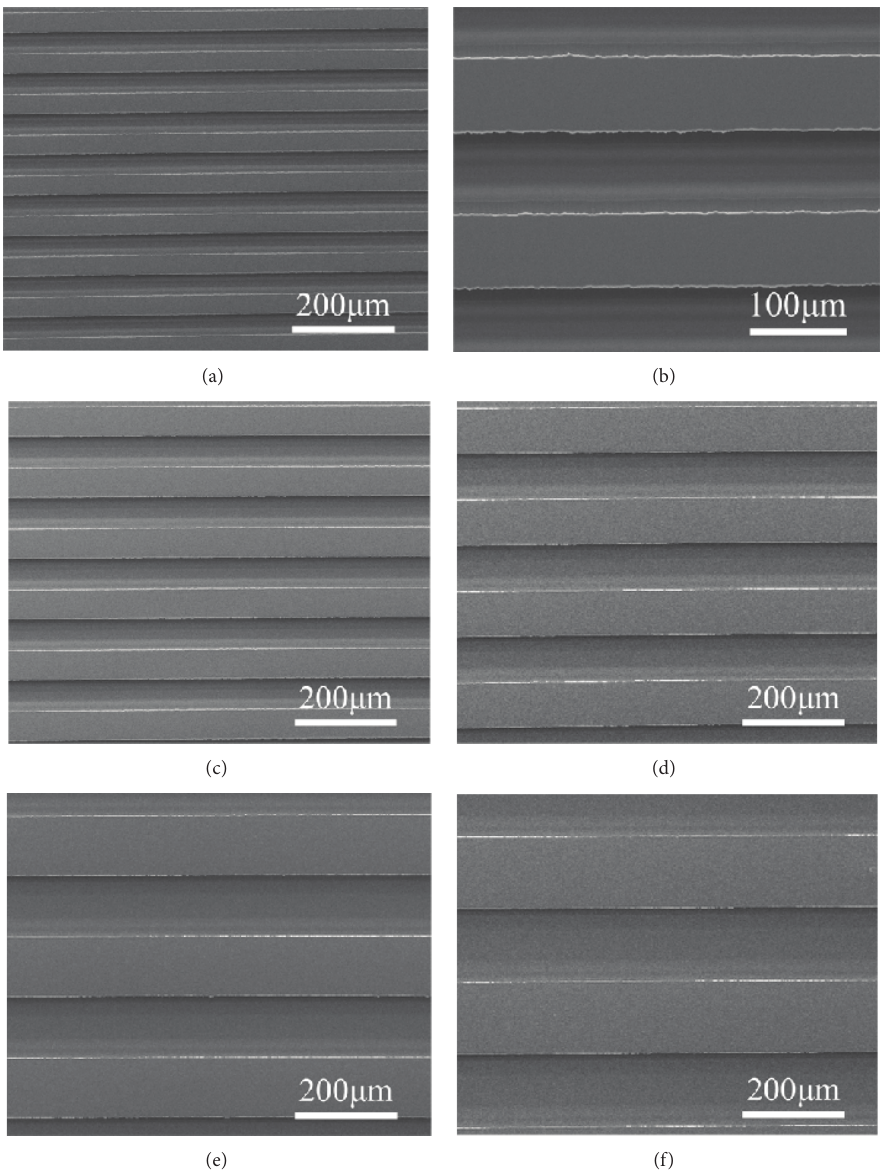
Figure 1: SEM images of grooved patterned Si substrate ( ℎ = 5 𝜇 m) of (a) 40/40 𝜇 m, (b) high-magnification image of 40/40 𝜇 m, (c) 60/60 𝜇 m, (d) 90/90 𝜇 m, (e) 120/120 𝜇 m, and (f) 150/150 𝜇 m.